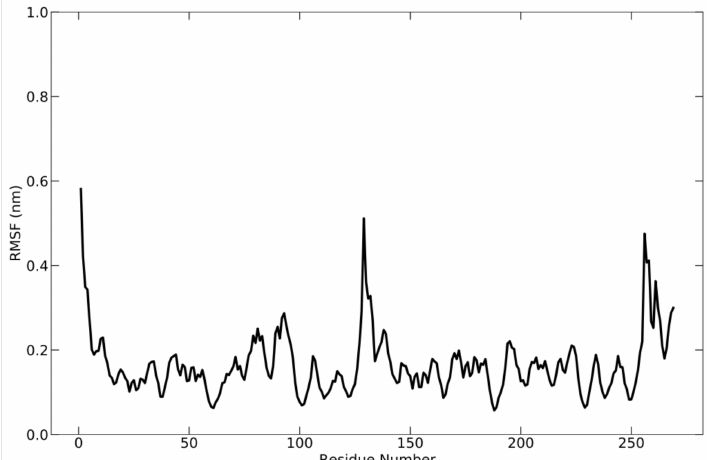
Figure 5. RMSF graph of the protein complex based on C-alpha atoms, which shows the fluctuation of each residue below 0.59 nm during simulation.